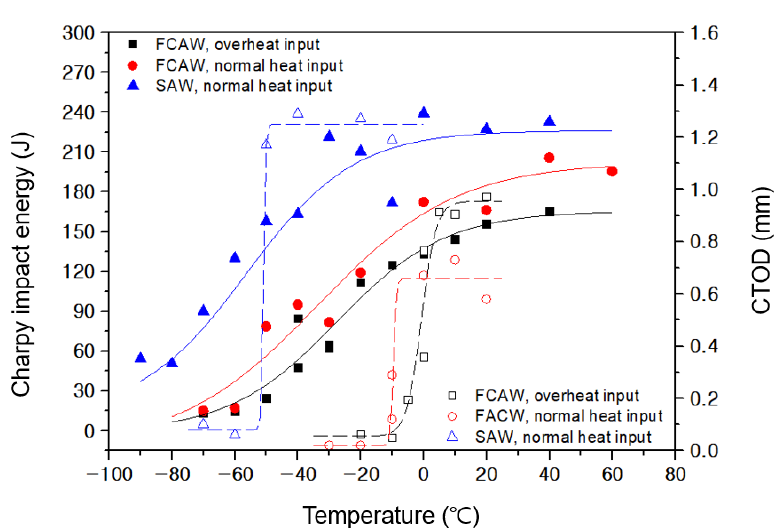
Figure 8. Comparison of ductile to brittle transition behavior according to test method.